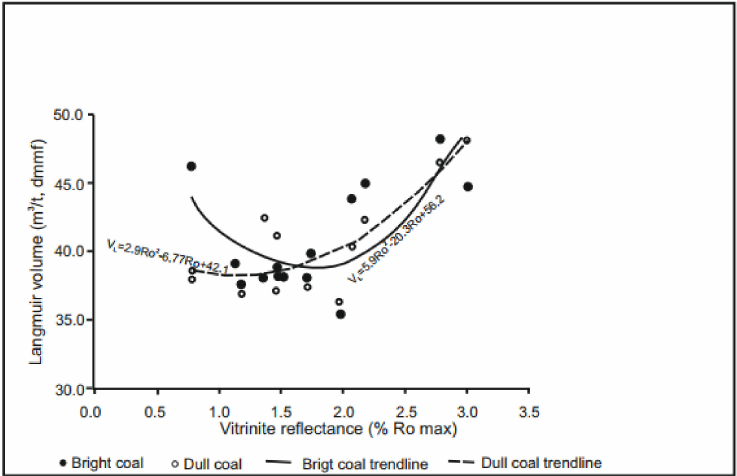
Figure 6. Trends in the Langmuir volume in relation to the coal rank